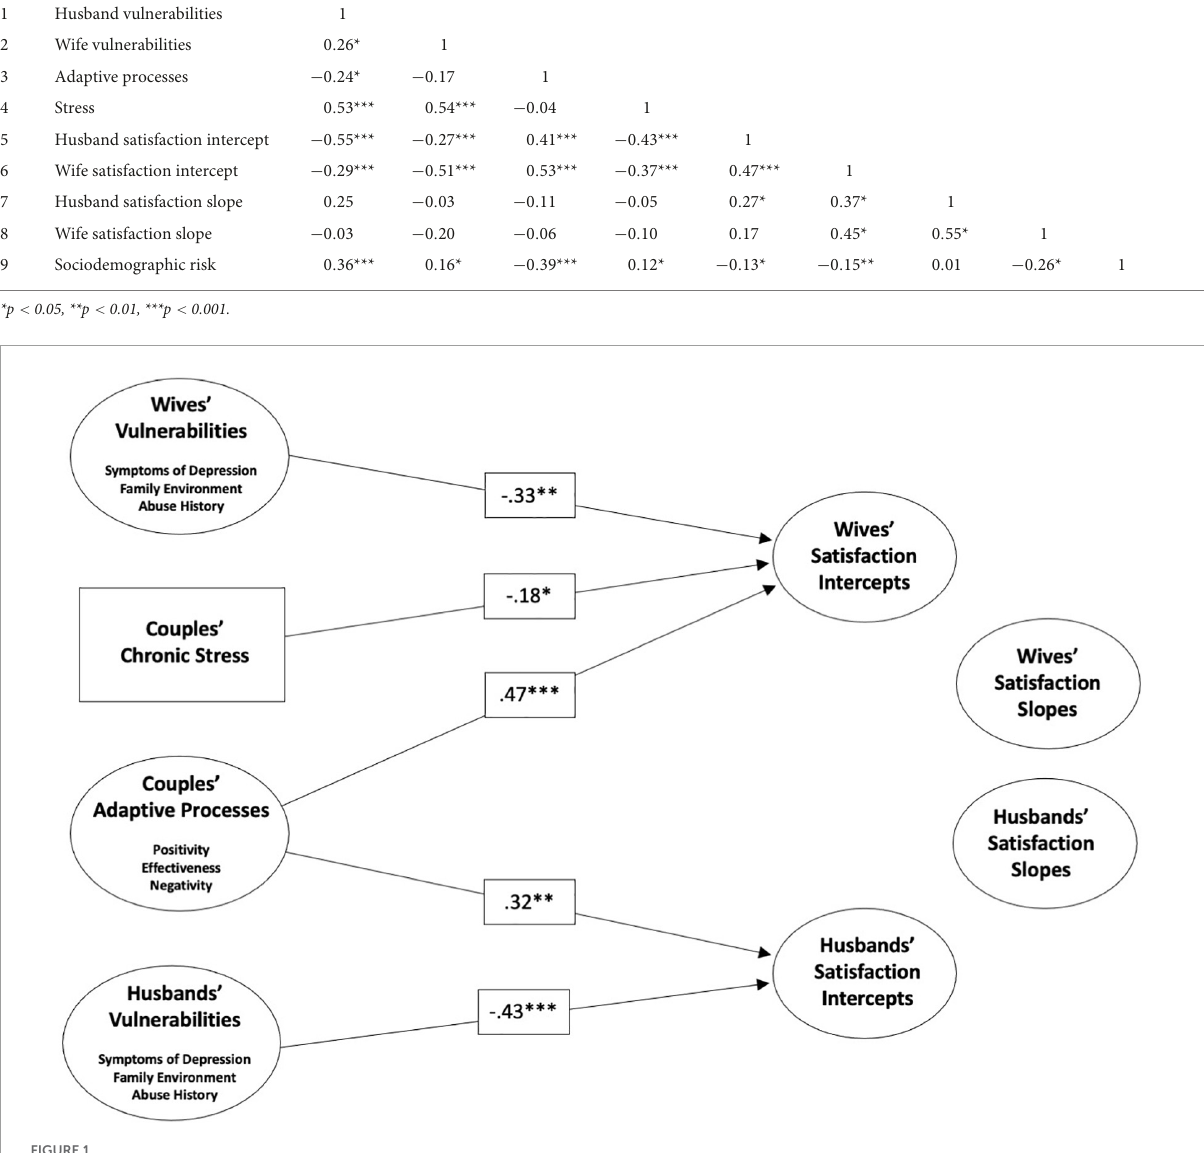
adaptive processes. The model tested indirect effects of stress and vulnerabilities mediated by adaptive processes on husbands’ and wives’ intercepts and slopes of satisfaction simultaneously using 5000 bootstrap simulations. We elected bootstrapping methods for testing indirect effects because of their superior statistical power compared to traditional techniques (Zhao et al.,